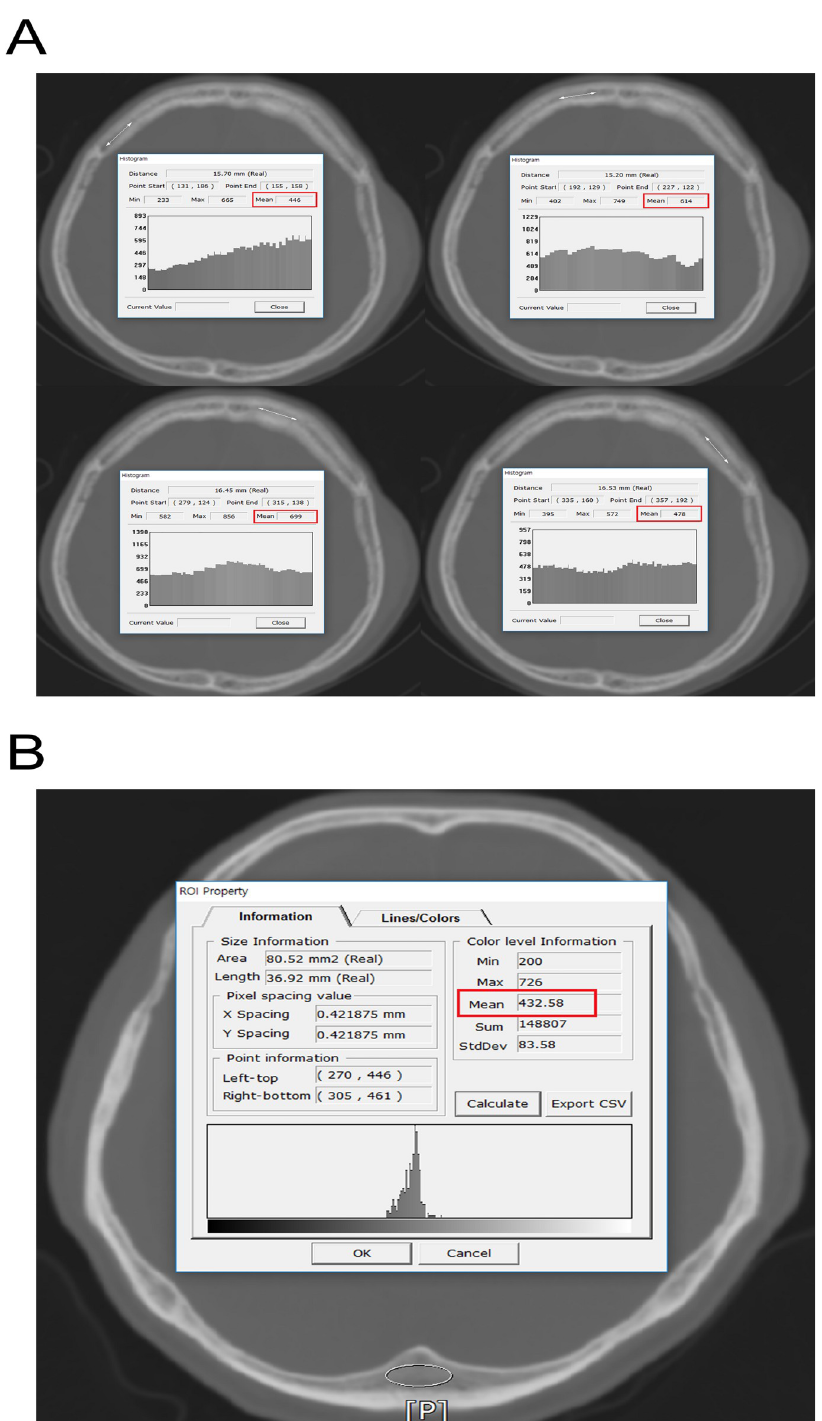
Fig 1. Measurement of HU values at frontal bone and IOP. (A) Measurement of HU values at each of four lines on the frontal bone (right lateral, right medial, left medial, and left lateral). The PACS automatically calculated the maximum, minimum, and mean HU values according to the values on the drawn line, and the mean HU value on each of the four lines was recorded. (B) Measurement of HU values at IOP. The PACS automatically calculated the maximum, minimum, and mean HU values according to the oval ROI. The mean HU value was used for the study. HU = Hounsfield unit; IOP = internal occipital protuberance; PACS = picture archiving and communication system; ROI = region of